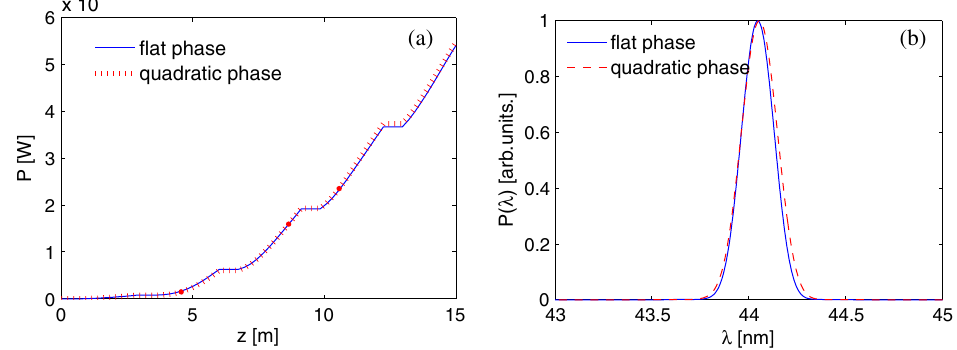
FIG. 13. 6th harmonic radiation performances of HGHG for the 16 fs seed laser pulses with flat phase (blue line) and quadratic phase (red dashed line): (a) FEL gain curves; (b) spectra at saturation.